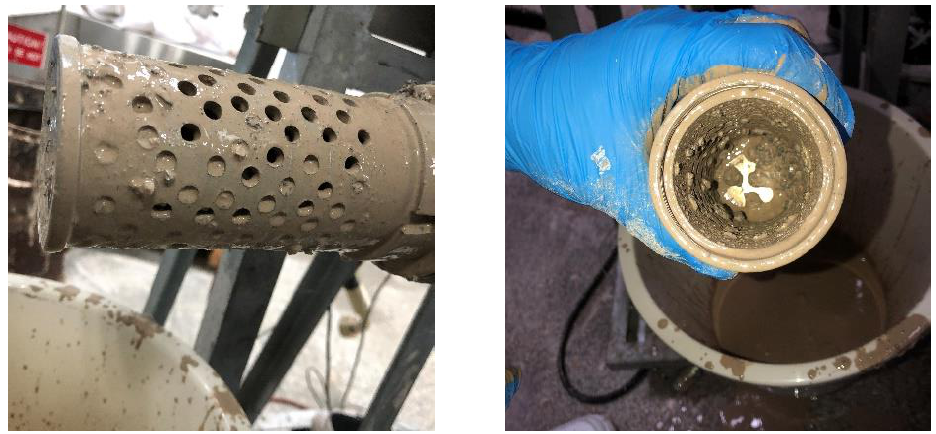
Figure 8. LCMs pass smoothly through the mud screen tool.